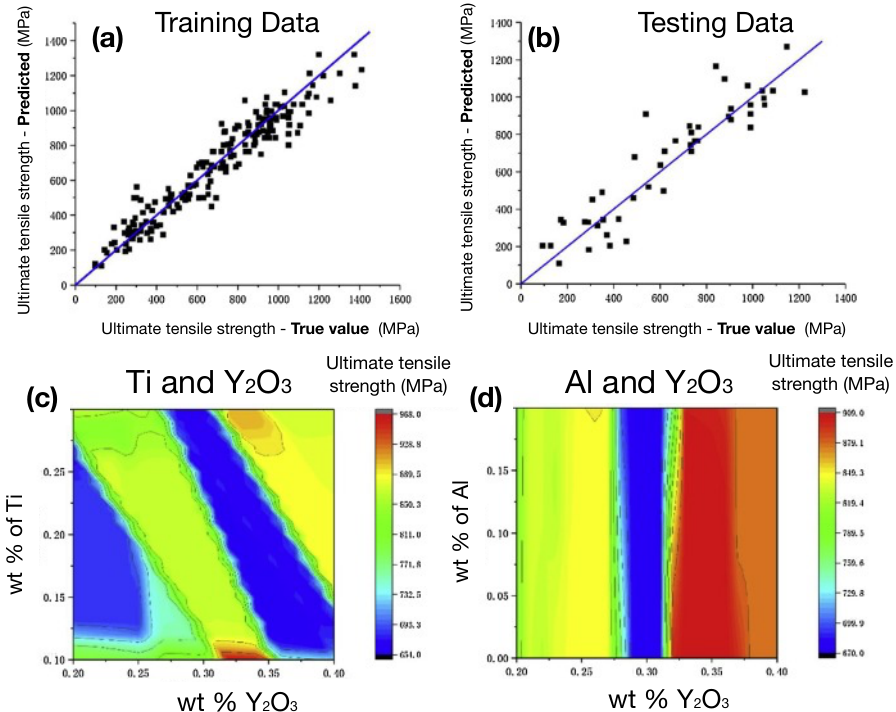
Figure 4. Integrated materials informatics to discover high-strength ductile alloys. A yield strength model was utilized quantitatively to identify contributions of solid-solution strengthening and grain refinement hardening into composition-structure-property relationships. ( a , b ) Model validation on the prediction of yield strength, ( c , d ) prediction of composition-dependent strength. Adopted from Ref. [89] with permissions from